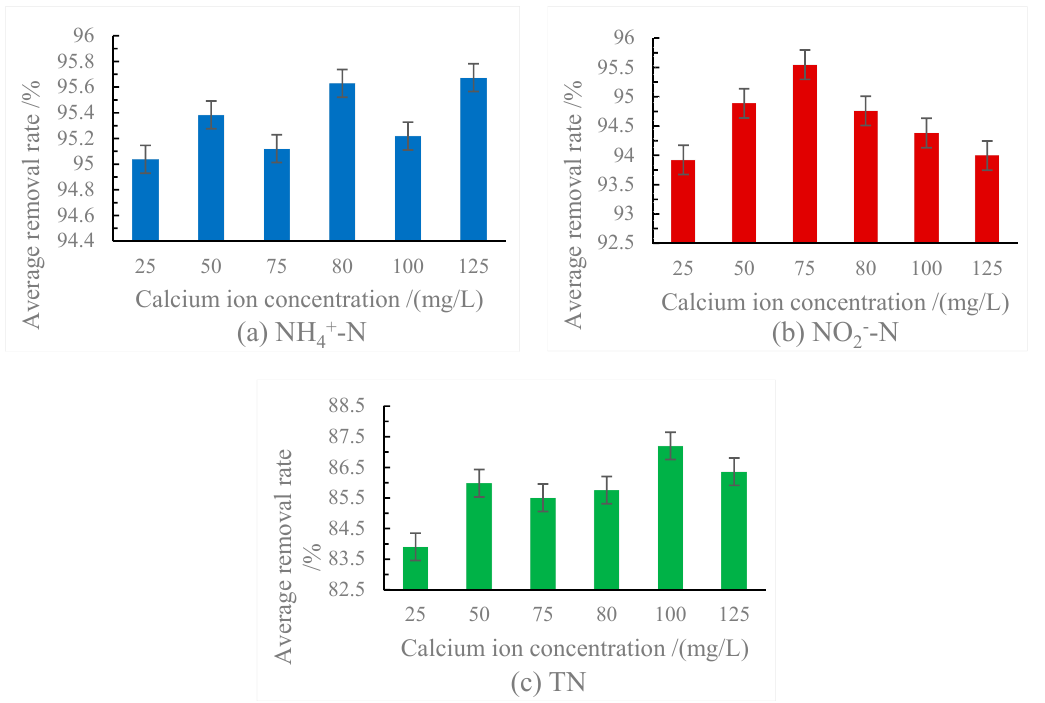
Figure 2. Removal of ( a ) NH 4 + –N, ( b ) NO 2 − –N, and ( c ) TN from the anammox reactor after 35 days of operation at different Ca 2+ concentrations.